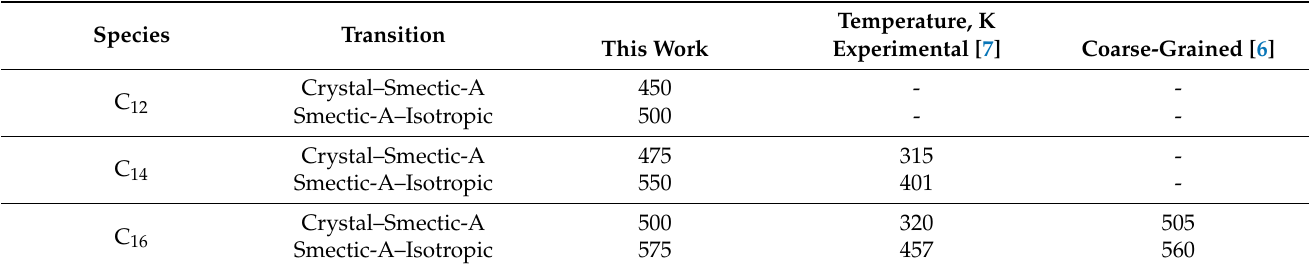
Table 1. Observed transition temperatures (upper bounds) between the various phases for this series of ionic liquid crystals. Guillet et al. [7] did not observe any smectic phase for [C 12 MIm][NO 3 ], but observed the isotropic phase above 302K. As a function of alkyl tail length, the trends of transition temperatures are consistent with experimental results